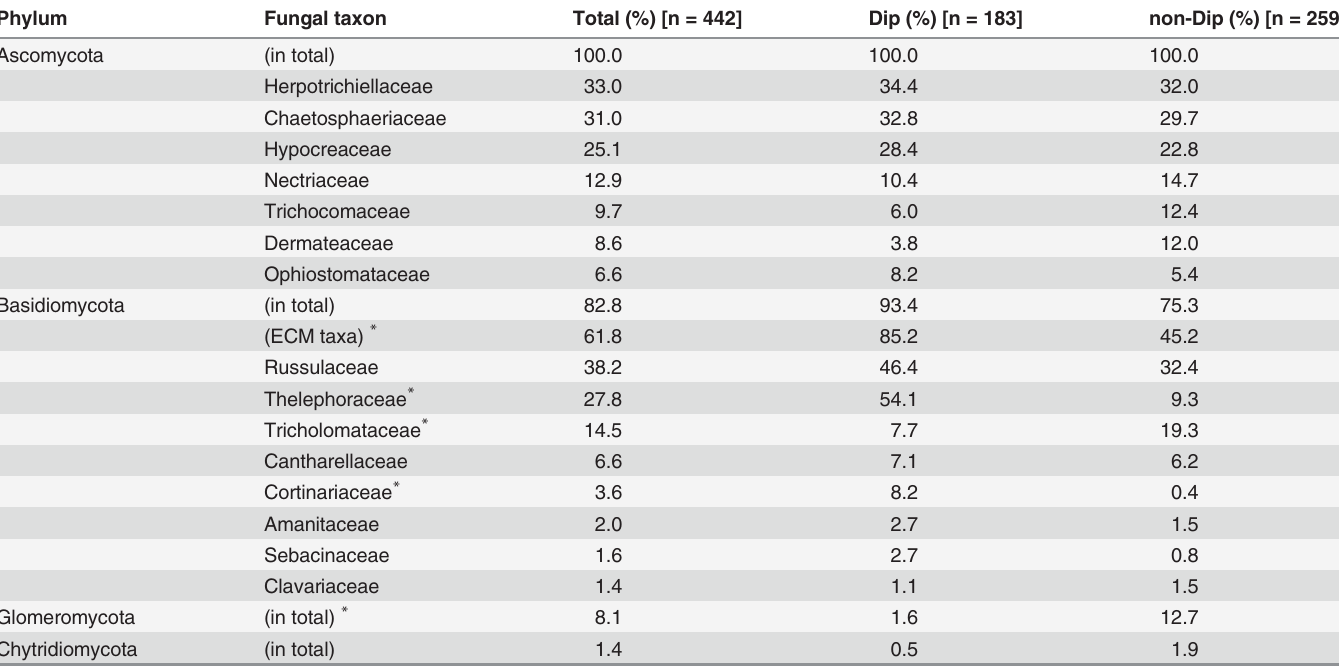
Table 1. Frequency of occurrence of each fungal taxon in root samples of dipterocarp (Dip) and non-dipterocarp (non-Dip) host plants. Phylum